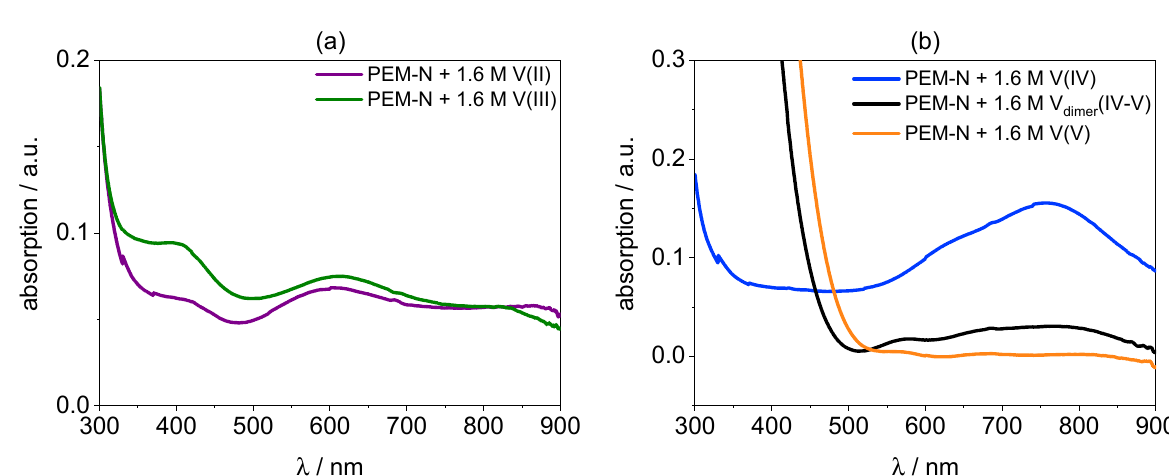
Figure 11. ( a ): UV/VIS spectra of a PVDF-based membrane hydrated with V(II) and V(III). ( b ): UV/VIS spectra of a PVDF-based membrane hydrated with V(IV), V dimer (IV–V) (corrected), and V(V) (corrected).